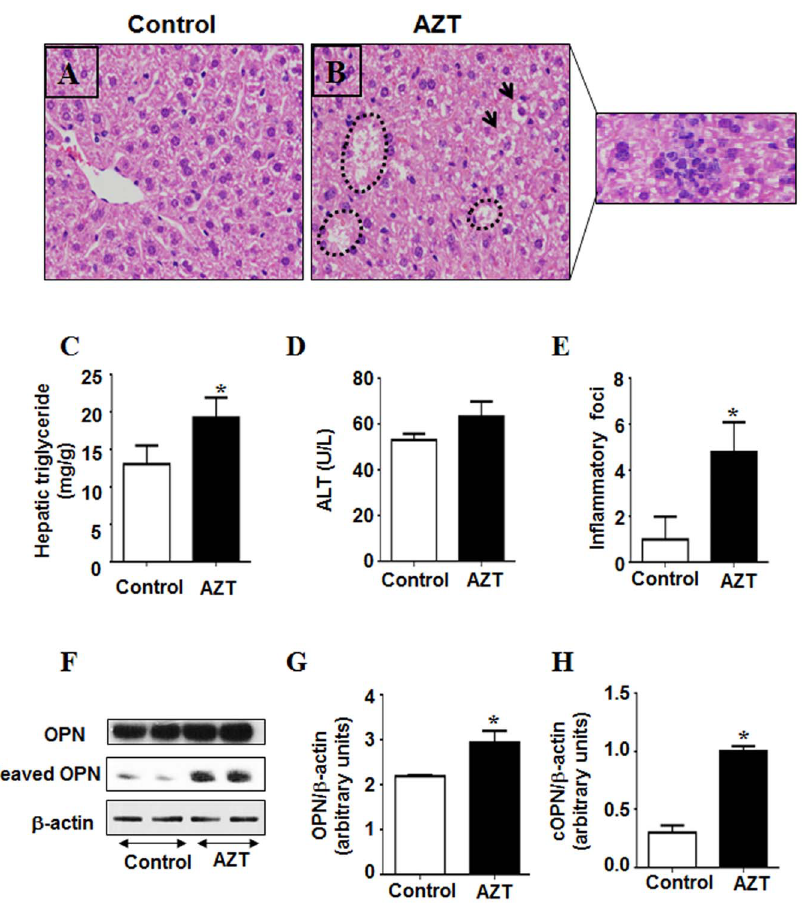
Figure 1. AZT-mediated hepatic fat accumulation, inflammation, and injury. (A, B) Representative photomicrographs of H&E stained liver sections from the indicated mouse livers are presented: (A) vehicle-control; (B) AZT–treated mice (outside inset: inflammatory foci as they are scattered). Accumulated fat are indicated by circular lines and arrows. (C) Hepatic triglyceride levels, (D) Serum ALT levels, and (E) inflammation foci (per 5 high power fields) are presented for the different groups. F) Equal amounts of total liver homogenates (50 m g/lane) from different groups were used to evaluate the amounts of full-length OPN, cleaved (active) OPN and b -actin protein (as a loading control). (G, H) Densities of full-length OPN and cleaved OPN (cOPN) protein bands were normalized to that of the b -actin. *Significantly different from the control group (n=6/group). Data indicate mean 6 SE, p , 0.05. All experiments have been conducted three times.